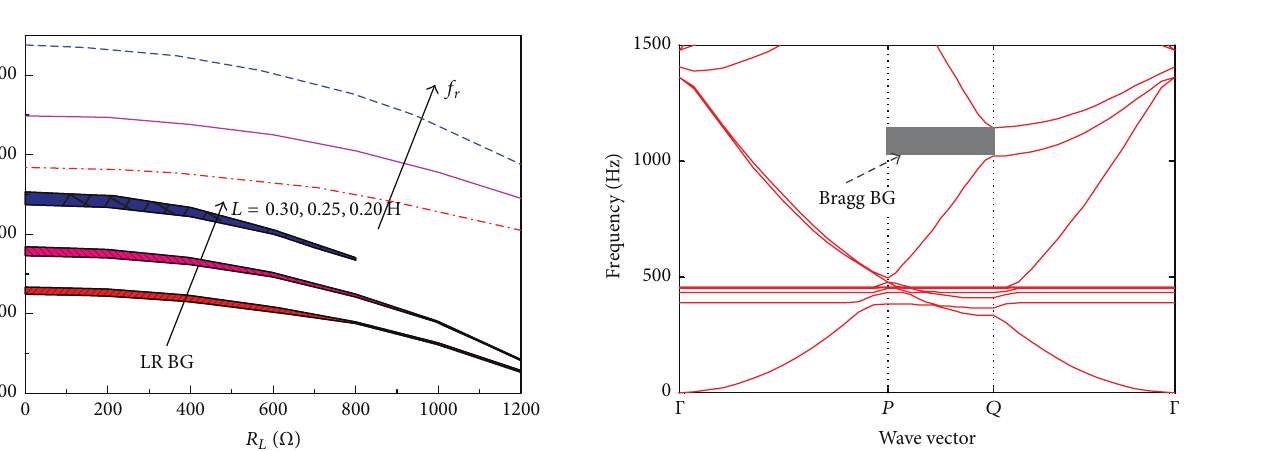
Figure 8: Distribution of the LR band gap of the two-dimensional PPC-C versus the resistance for different inductance.